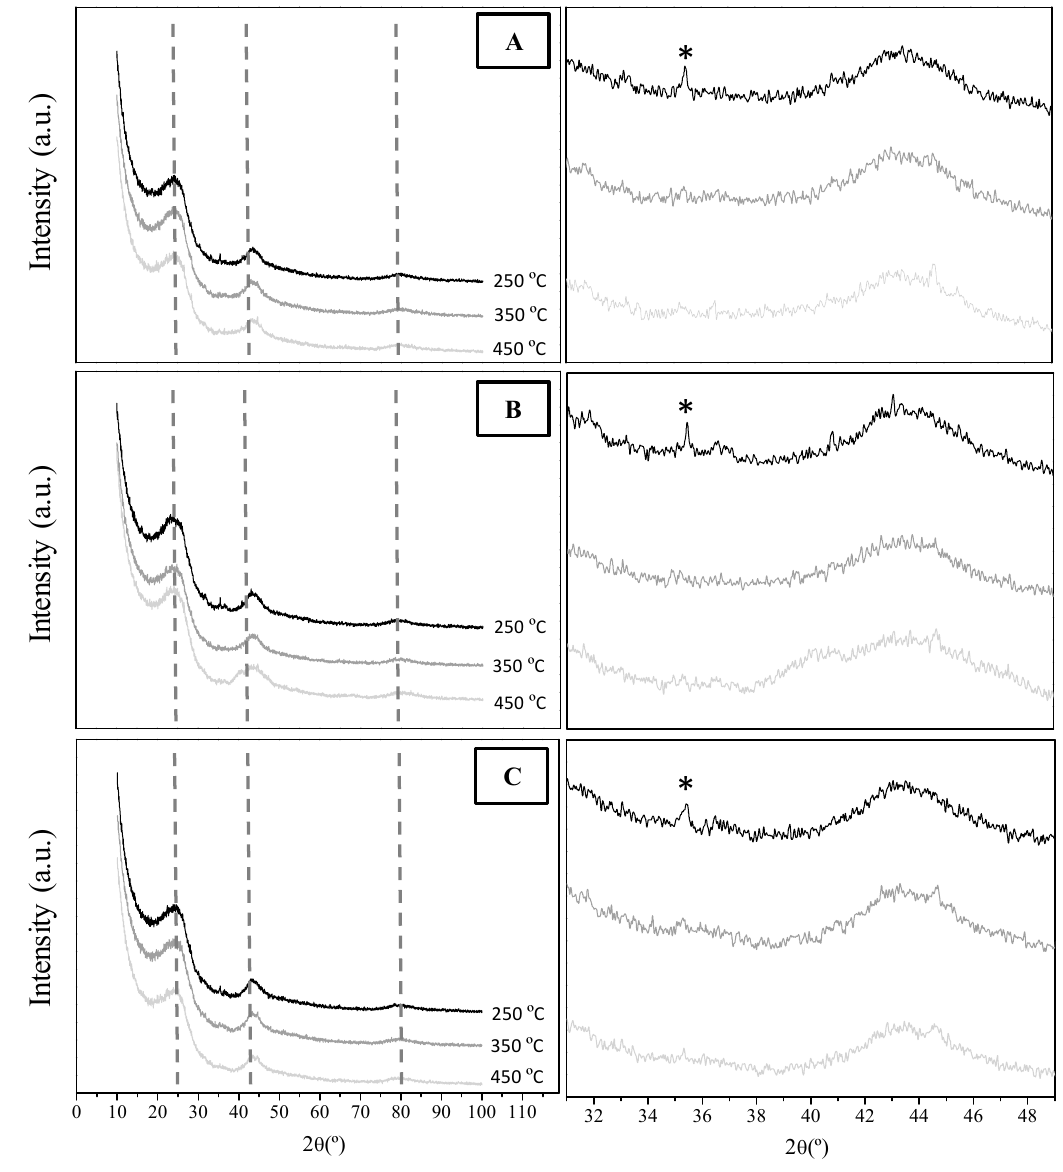
Figure 3. XRD diffractograms of: ( A ) Pt/C; ( B ) Pd/C; ( C ) Rh/C.